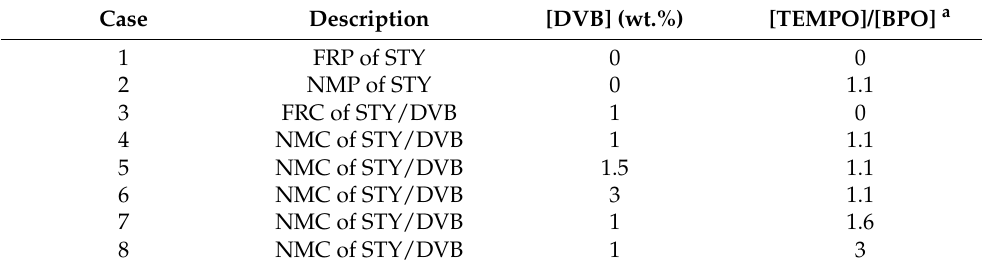
Table 1. Cases of homopolymerization of STY and copolymerization of STY/DVB in scCO 2 , either conventional or